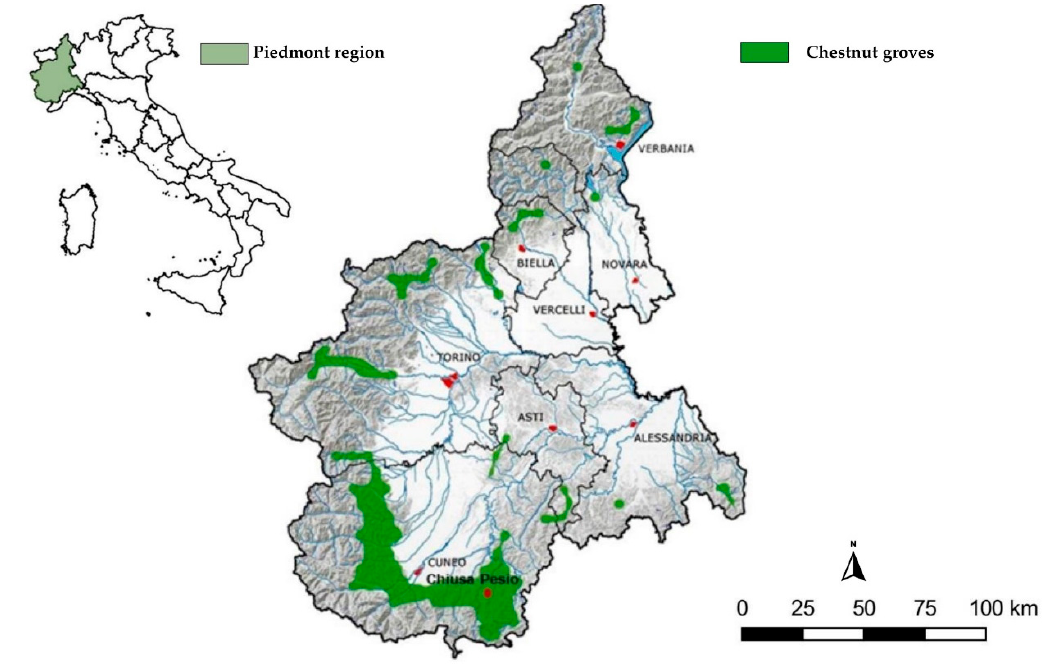
Figure 1. Localization of chestnut groves in Piedmont region (Italy).